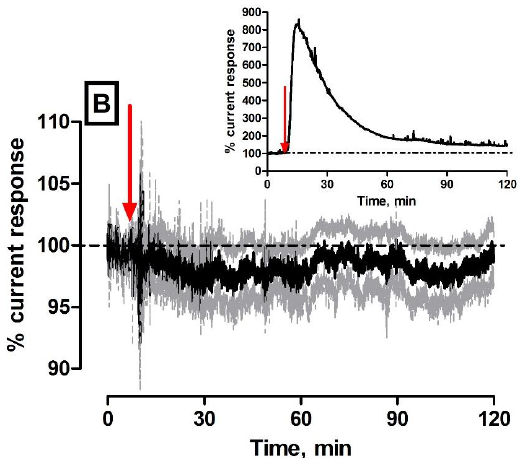
Figure 5. Averaged raw data percentage response of subtracted amperometric current from H 2 O 2 biosensor implanted in the striatum of NOD SCID mice to: ( A ) 1 mL·kg −1 injection of 0.9% saline ( n = 6); and ( B ) 500 mg·kg −1 injection of sodium ascorbate ( n = 5). Inset: Typical example of raw data percentage response of a bare Pt 1 mm cylinder electrode implanted in the striatum of a NOD SCID mouse to 500 mg·kg −1 injection of sodium ascorbate. Red arrow indicates point of injection. Mean percentage current response represented by black trace, percentage error represented by grey trace.